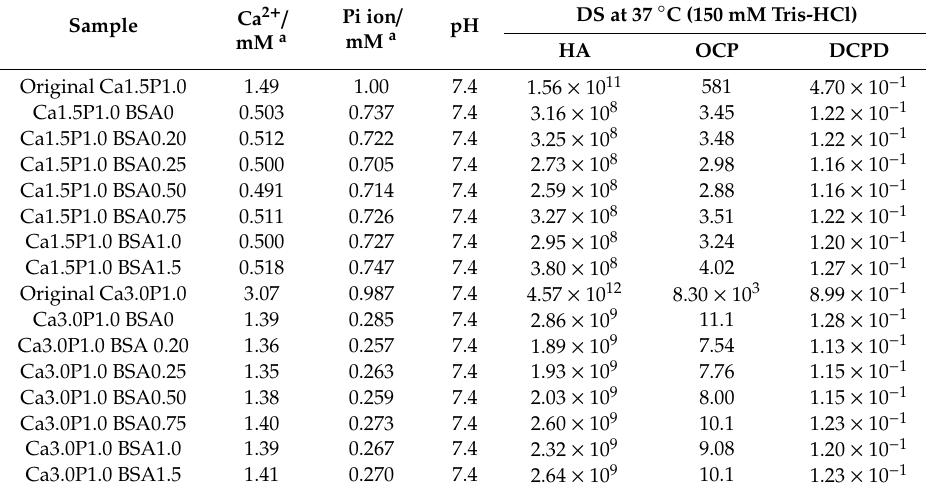
Table 2. Composition and degree of supersaturation (DS) of Ca1.5P1.0 and Ca3.0 P1.0 solution before and after incubation with OCP for 1